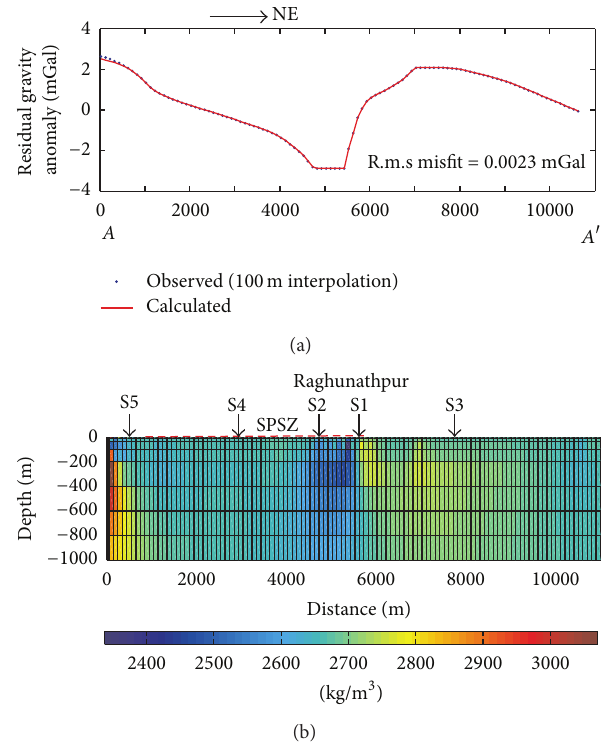
Figure 10: 2D residual gravity inverse model along profile AA 󸀠